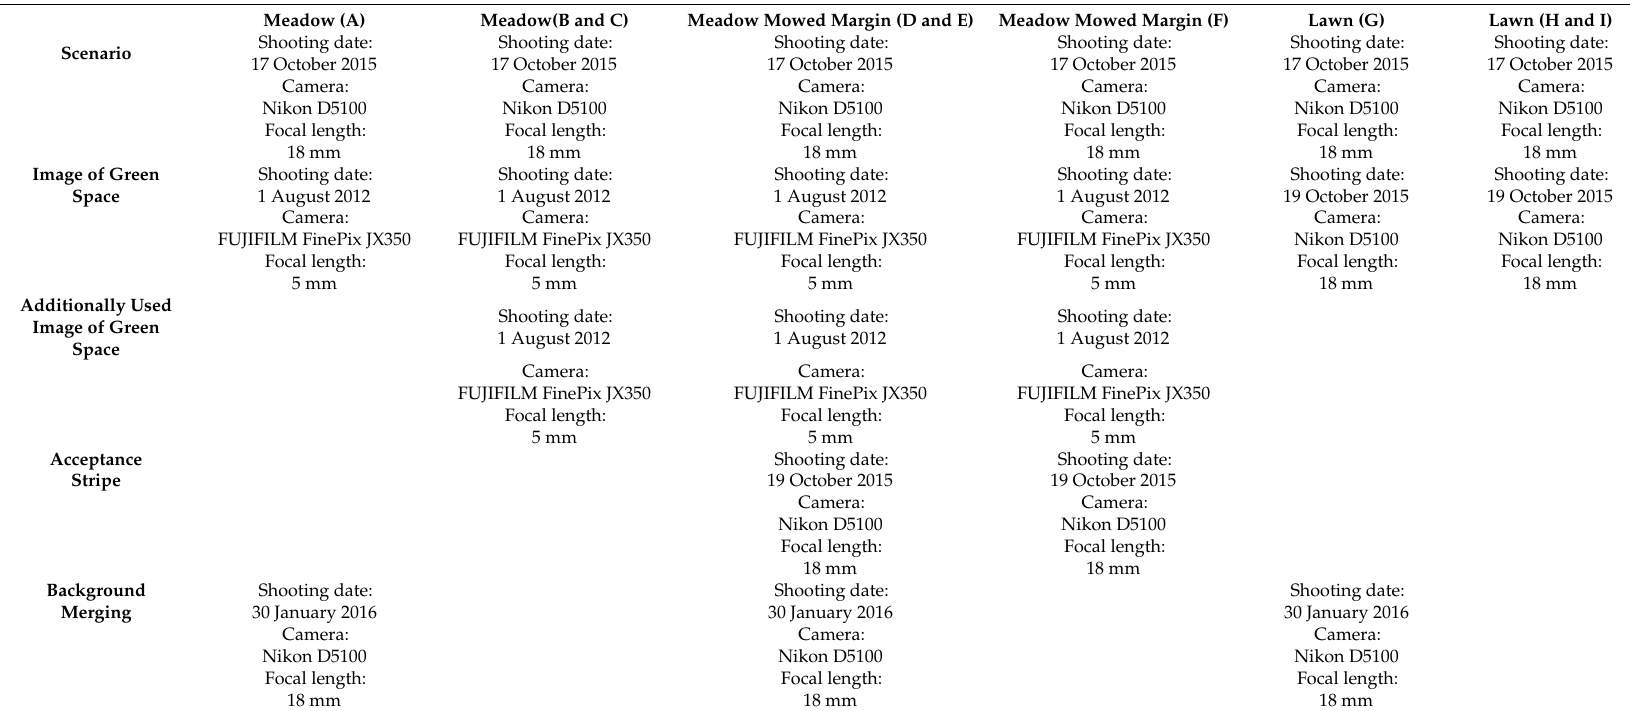
Table A7. Photo usage and details of Question